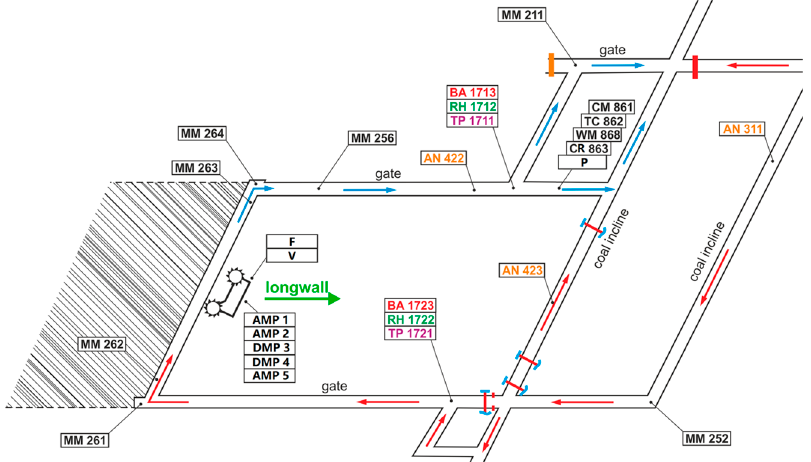
Figure 1. The layout of various sensors. The red arrows show the directions of air flow, and the blue arrows show the directions of gas flow.